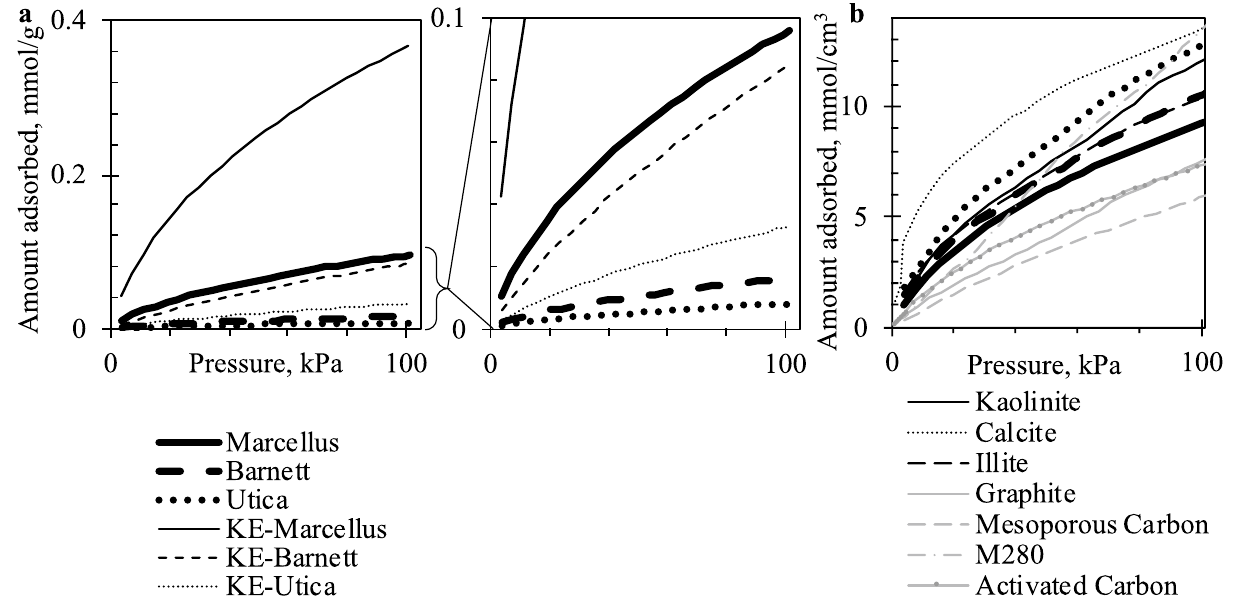
Figure 5. Amount of CO 2 adsorbed in mmol/g ( a ) and in mmol/cm 3 ( b ) at 26 °C. The data was used to plot heat of adsorption versus coverage and calculate fraction of CO 2 adsorbed on kerogen-enriched and acid- digested parts of shales.